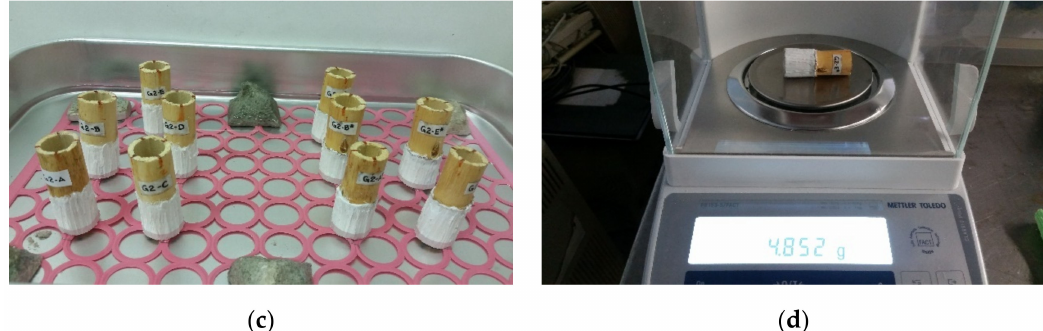
Figure 4. Capillary water absorption test steps: ( a ) sample preparation, ( b ) steel wire support, ( c ) samples immersed in water, and ( d ) weighing the sample on a precision balance.